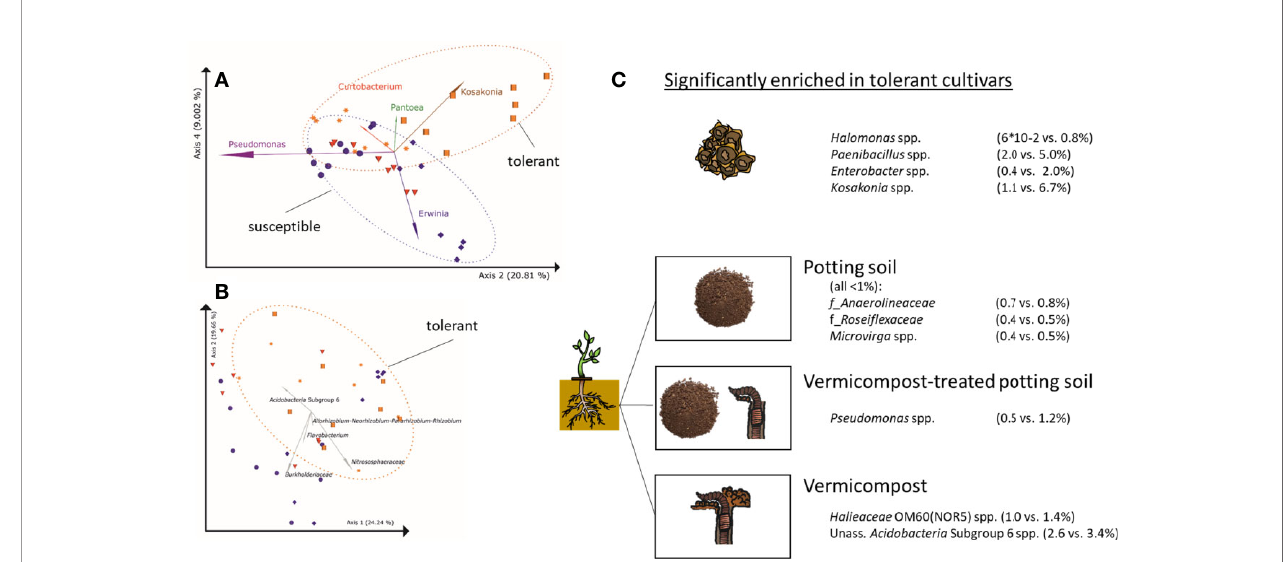
FIGURE 5 | Differences in bacterial root communities between Rhizoctonia solani -susceptible (violet), effective (red) and – tolerant (orange) cultivars (A) PCoA-biplot of Bray-Curtis dissimilarities in seeds on genus level; spheres: cv. BELLADONNA; diamonds: cv. BERETTA; triangles: cv. ISABELLA; squares: cv. LAETITIA; stars: cv. MATTEA. Note, that PCoA axes 2 and 4 separate the communities based on Rhizoctonia tolerance, while axes 1 and 2 separate them due to their origin ( Figure 2B ). For the visualization of the other combinations of PCoA axes, see Supplementary Figure 1 . (B) PCoA-biplot of Bray-Curtis dissimilarities in roots on